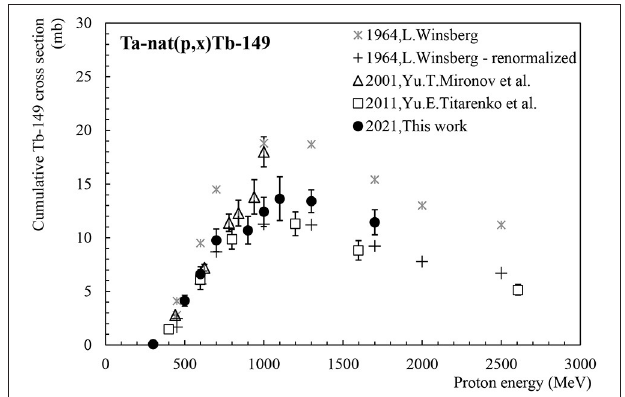
FIGURE 2 | Cumulative cross-section for Ce-139 production as a function of the proton beam energy.